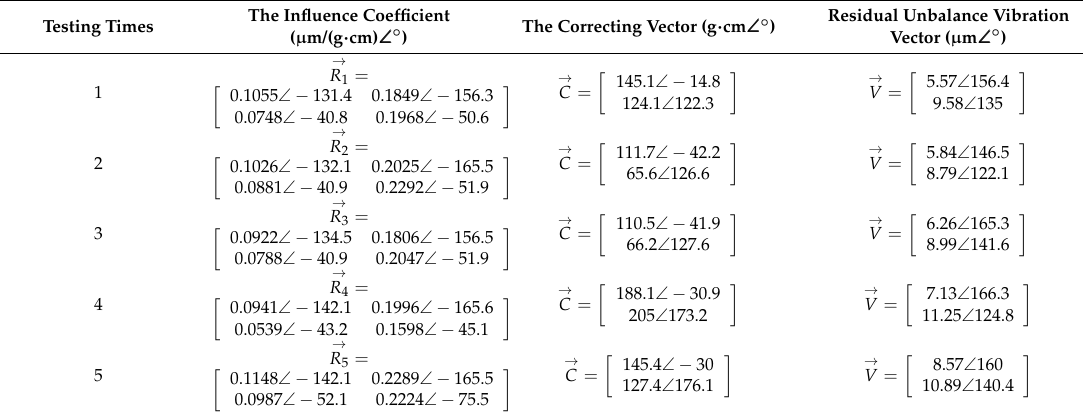
Table 1. The results of trial weight and dynamic balance experiments of the influence coefficient method.